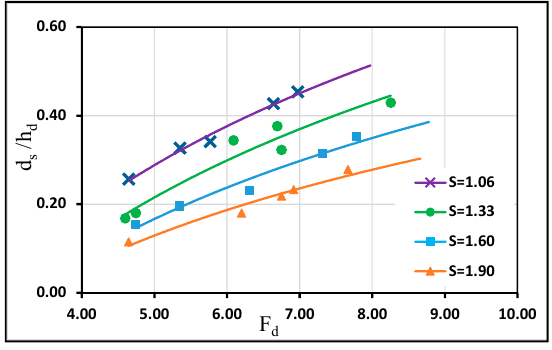
Figure 4. Relationship between (d s /h d ) and (F d ) for different S and Ar = 0.00.